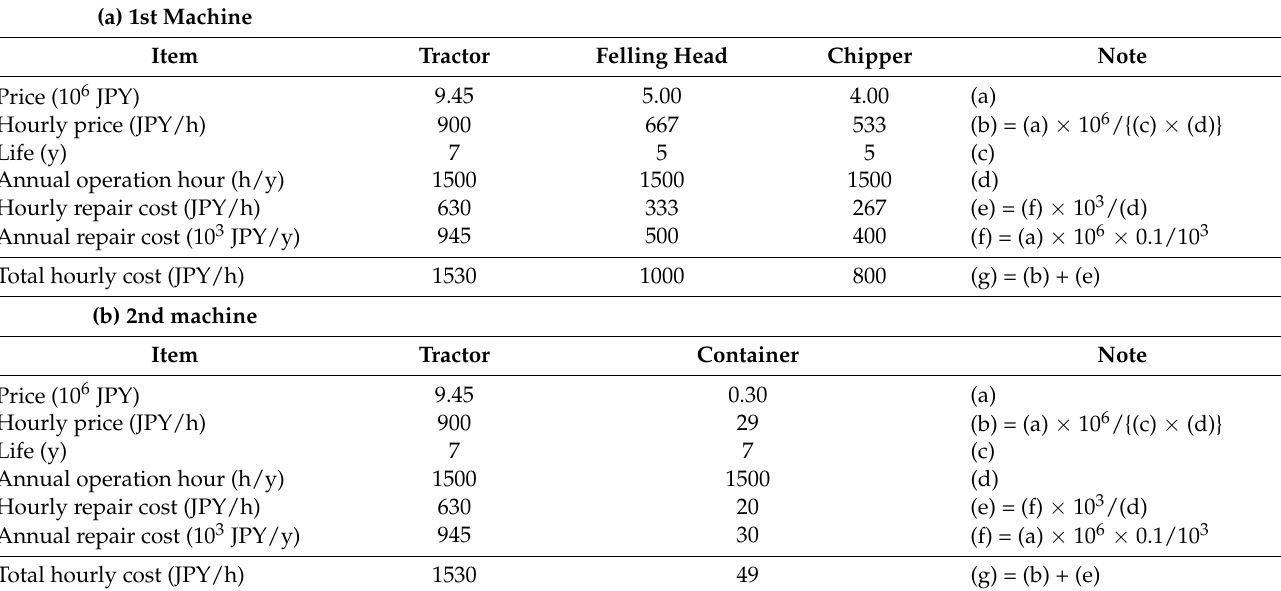
Table 5. Detail of calculating the hourly costs of the two